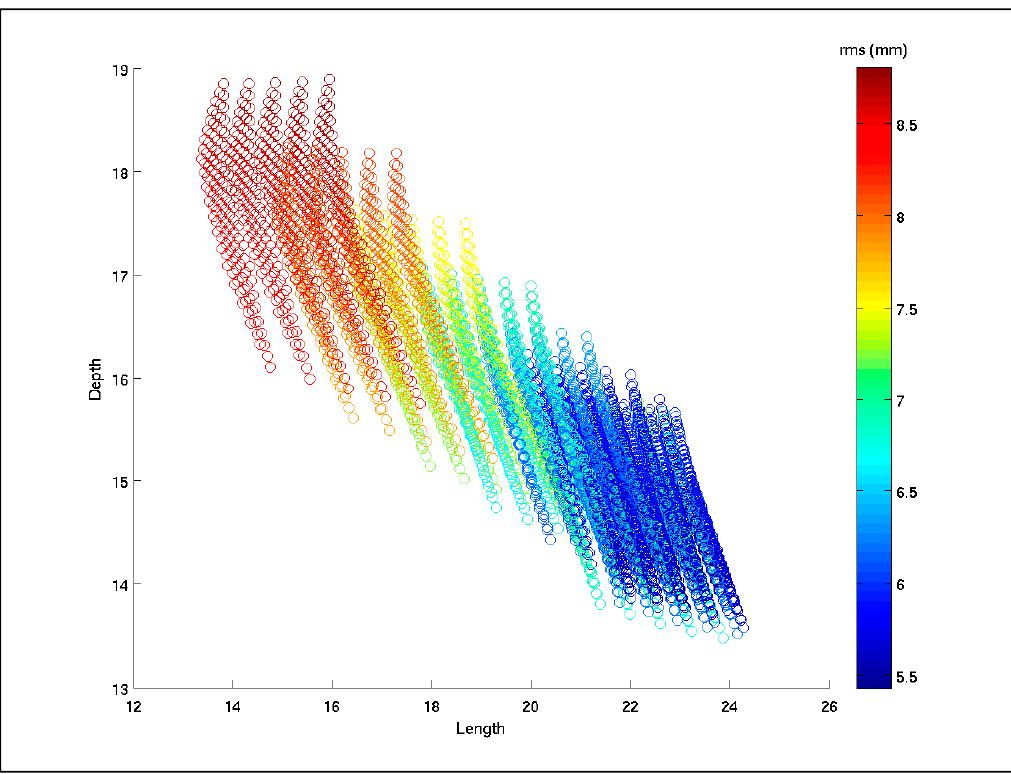
Figure 4. Diagram of depth (of the top-edge of the fault; Y -axis) versus fault length ( X -axis), with the values of root mean square (r.m.s.) error in colour of the inversions output (see vertical scale bar). The inversion series is converging to the lowest r.m.s. at a depth of 14 km and length of 22 km.